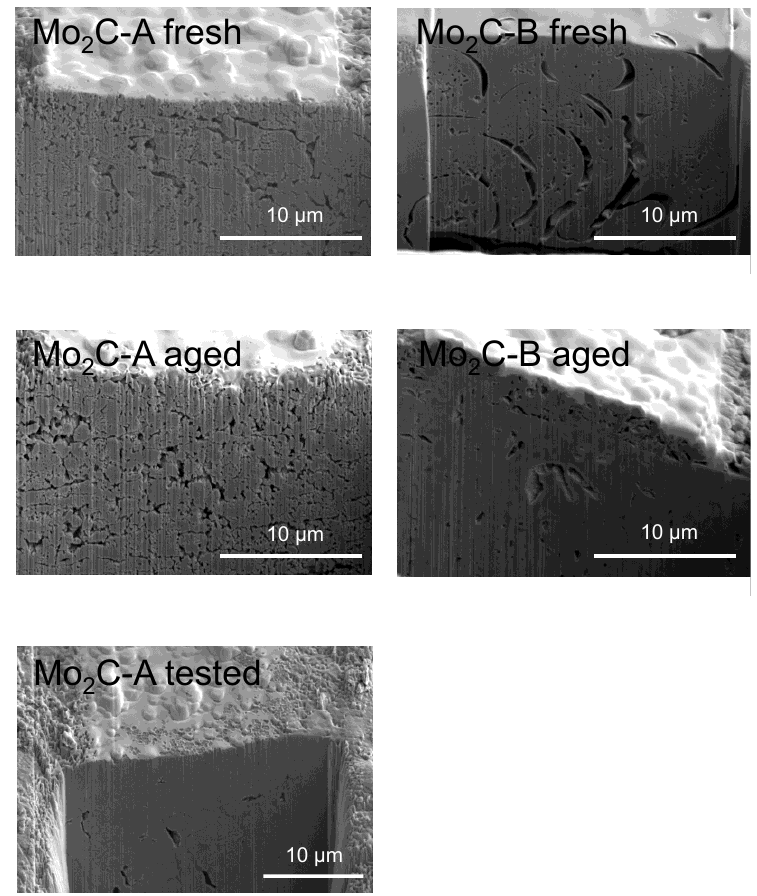
Figure 4. FIB-SEM images of the two Mo 2 C samples (A and B) before and after aging for 48 h in hot liquid water. The image for Mo 2 C-A obtained after a 48 h aqueous-phase hydroprocessing run (10% guaiacol in water as feed) is also presented for comparison (Mo 2 C-A